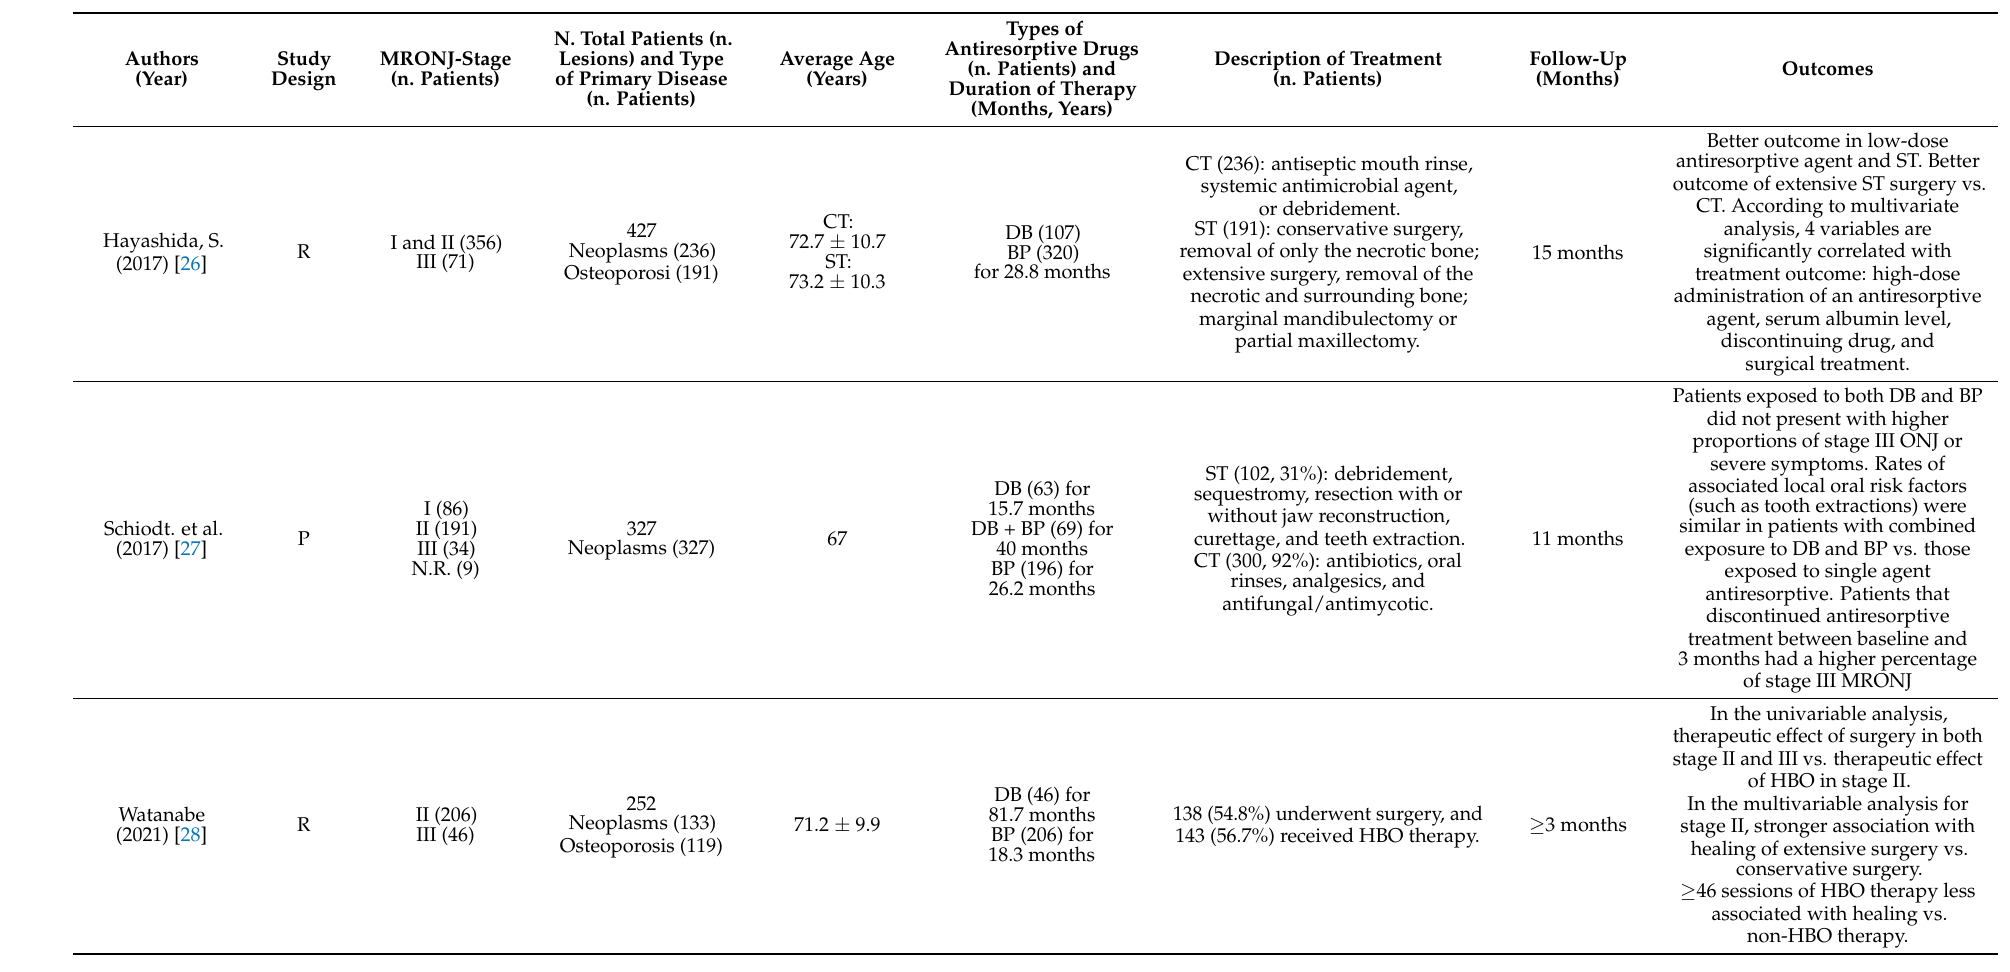
Table 2. Descriptive summary of item